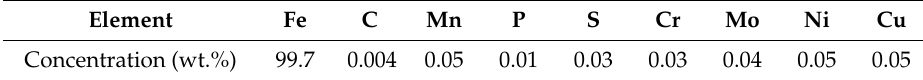
Table 8. Element content (wt.%) of reduced iron, Experiment